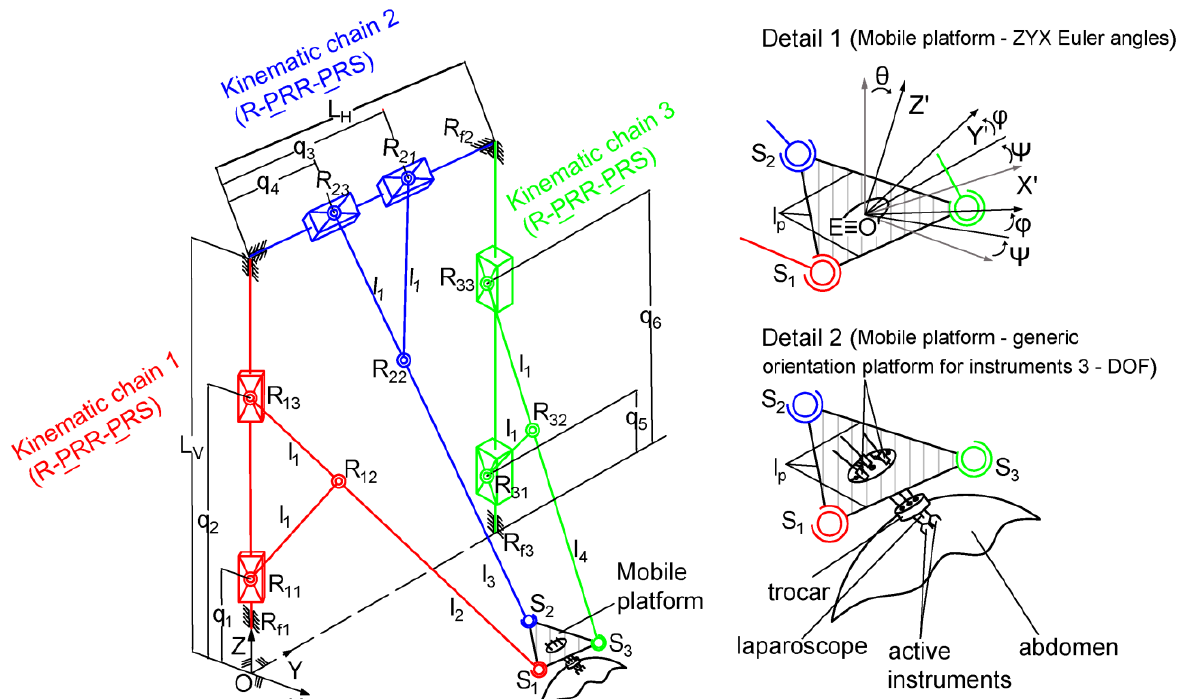
Figure 2. Kinematic scheme of the 6-DOF parallel robot for SILS.